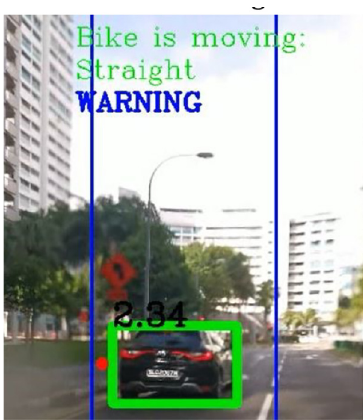
Figure 8 Algorithms integrated example